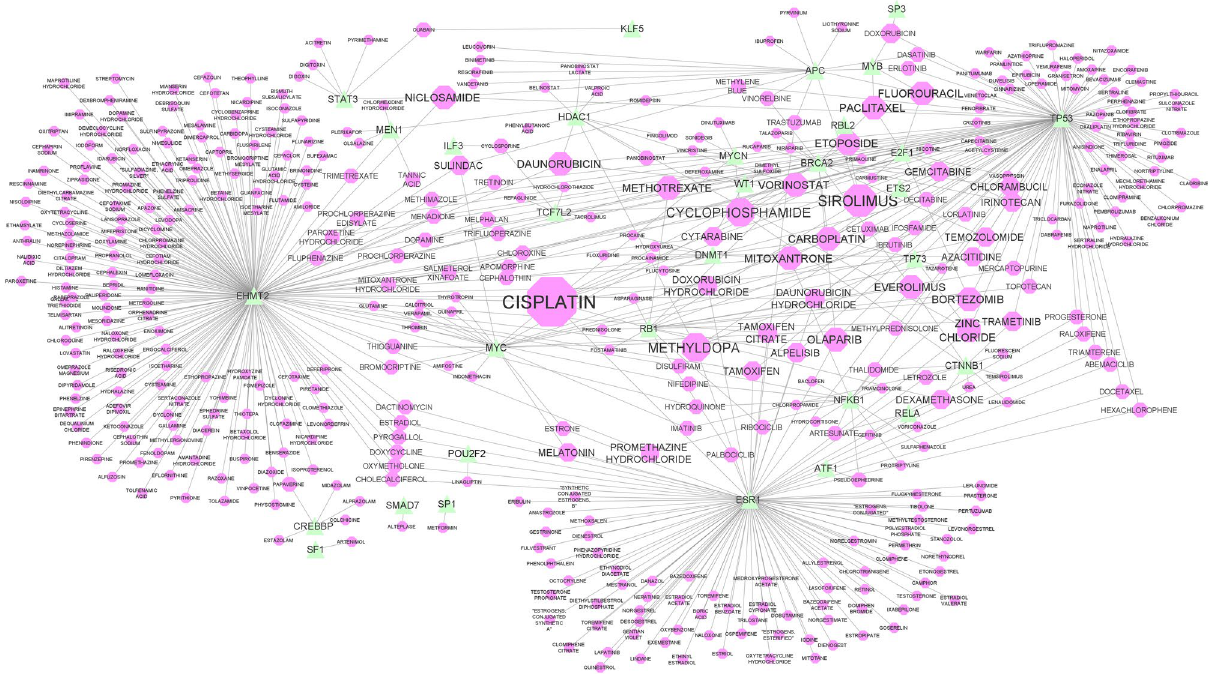
Figure 4. Drug-TF interaction network for TF-miRNA-TG_A and TF-miRNA-TG_B sub-networks. Green triangle shapes show genes, and pink octagon shapes show drugs. The size of the octagon nodes indicates its degree. The high degree drug is CISPLATIN with 11 target